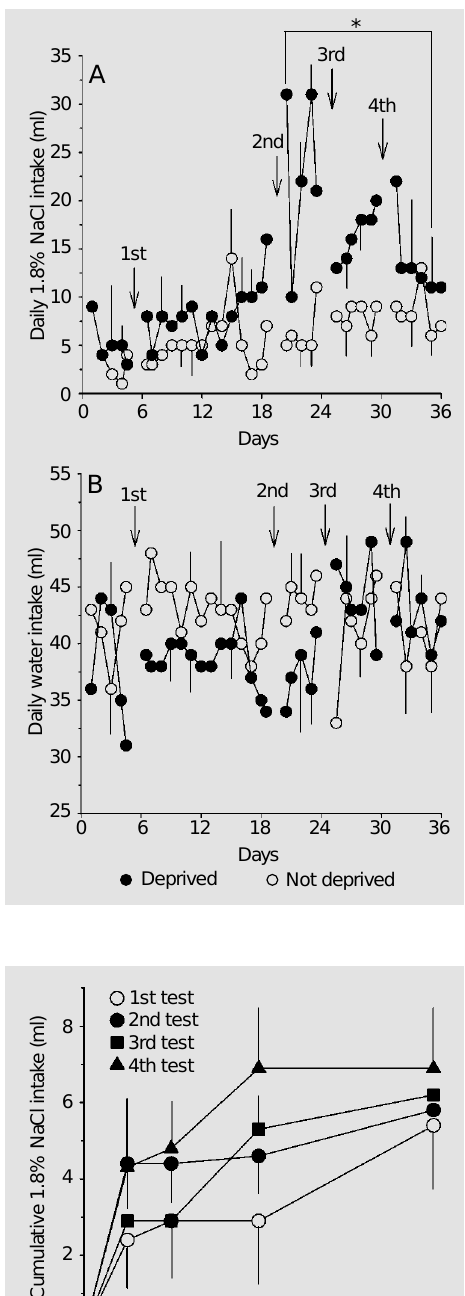
Figure 1. Daily intake of 1.8% NaCl (A) and water (B) by